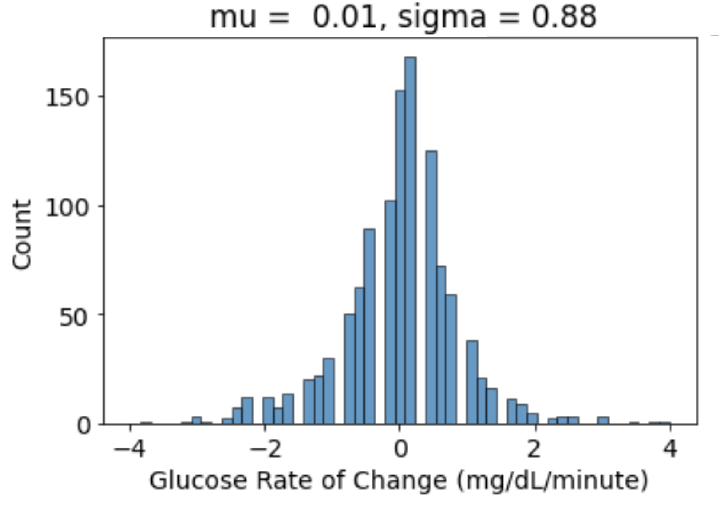
Figure A2. Visualisation for Glucose Rate of Change for an AID User. ‘Mu’ is mean and ‘Sigma’ is the standard deviation of